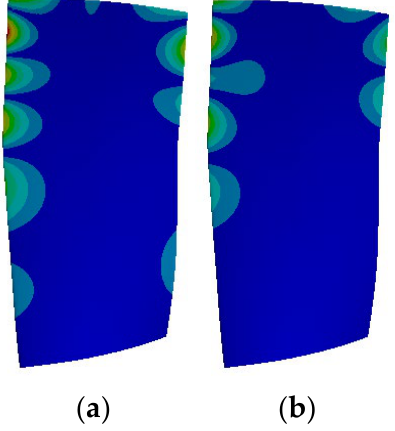
Figure 30. 45 EO displacement amplitude of R1 rotor blade. ( a ) C# ( b ) M#. Notably, the R1 for the twisted blade, blade, and shock wave positions is different at different blade spans, while the upstream downstream S1 blade affects the direction of propagation of the plate. These factors result in the different superposition relationships of the influences of struts and IGV at different blade spans, resulting in a difference in the pressure amplitude distribution at the 40–90% blade span after the shock wave on the R1 blade suction surface in Figure